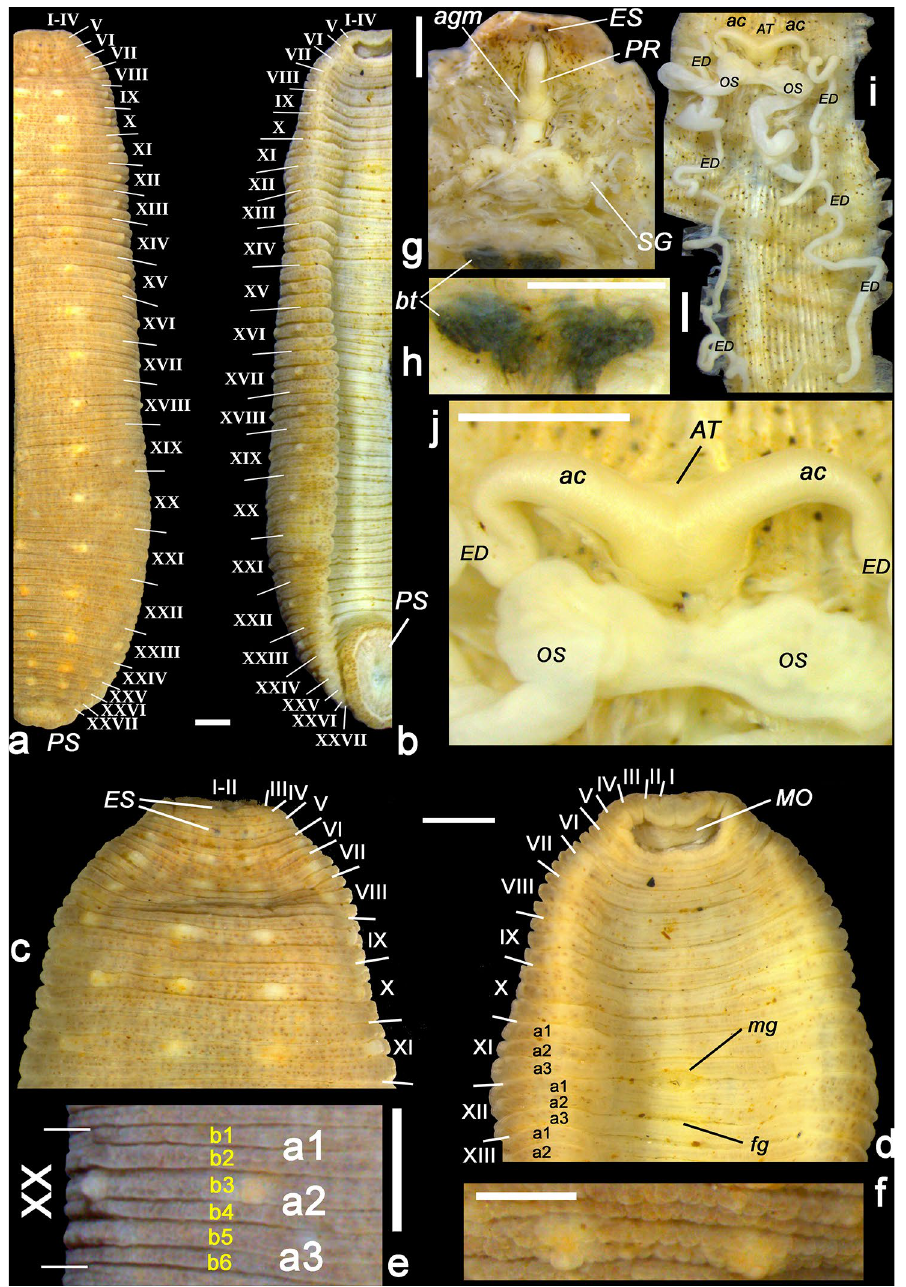
Figure 6. Morphological and anatomical features of Hyperboreomyzon polaris gen. & sp. nov. (paratype RMBH Hir_0216, Kolguev Island). ( a , b ) Body annulation in dorsal ( a ) and ventral ( b ) view. ( c , d ) Anterior region in dorsal ( c ) and ventral ( d ) view. ( e ) Example of a sexannulate mid-body somite (left half of XX) with six secondary semi-annuli (b1–b6). ( f ) Enlarged fragment of a somite, showing characteristic ‘fish scale’-like papillation (dorsal view). ( g ) Dissected anterior region (dorsal view) showing proboscis sheath, salivary glands, and the patch of black tissue of unknown function, covering the dorsal surface of the atrium. ( h ) Close up view of the black tissue patch (dorsal view). ( i ) Generative system (dorsal view). ( j ) Atrium. ES eyespots, MO mouth, PR proboscis sheath, agm anterior ganglionic mass, bt black tissue, SG salivary glands, AT atrium, ac atrial cornua, ED ejaculatory ducts, OS ovisacs, mg male gonopore, fg female gonopore, PS posterior sucker. Body somites are indicated by roman numerals. Scale bars = 1.0 mm ( a – d , f – i ) and 0.5 mm ( e ). Images of the leech body ( a – d , f ) were lightened using a Brightness/Contrast tool of Adobe Photoshop CS v. 8.0 (see Supplementary Fig. S10a for natural coloration of this specimen). Photos: Anna L. Klass; graphics: Ivan N.